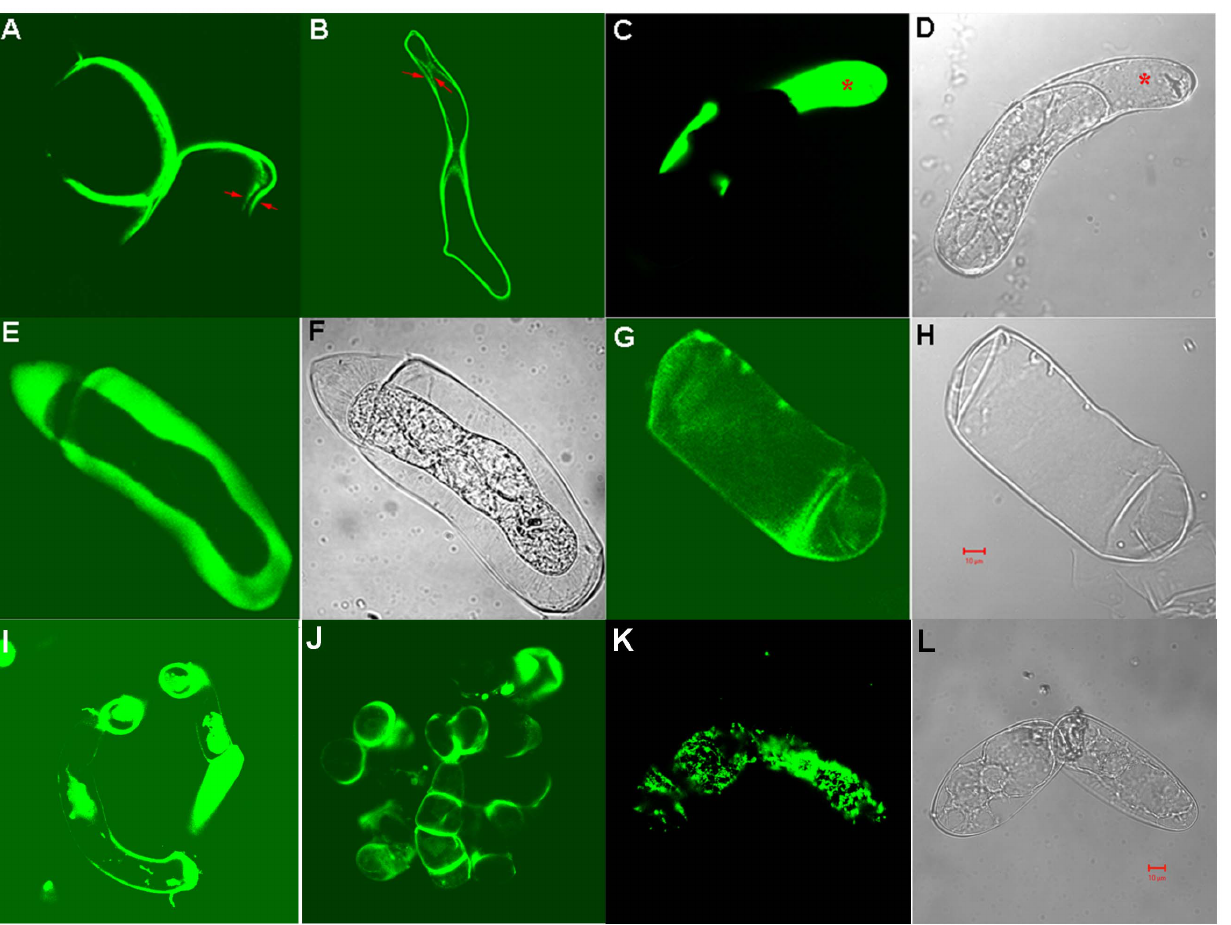
Fig. 3. Transgenic cells under confocal microscope. Panels A to H were images of 442-EGFP cells, among which cells in A to D were in liquid culture media. Arrows in A and B labeled the plasma membrane and cell wall respectively, showing 442-EGFP in the cell wall. The * labeled area of cell in C and D showed accumulation of 442-EGFP between the plasma membrane and the cell wall under normal suspension culture condition. Panels E and F were images of cells in 1 M mannitol, while G and H were cell walls prepared after sonication and wash with 2M NaCl and water. Panels I and J were images of 224-EGFP and 242-EGFP cells in 1 M mannitol, respectively; panels K and L were images of control YL8-EGFP cells in 1 M mannitol, in which the green fluorescence was mainly distributed on the plasma membrane. YL8-EGFP stands for gene encoding (SP 4 SPSP 4 YYYL) 8 -EGFP fusion protein [17]. Except panels D, F, H, and L were taken under normal light, other panels showed cells under excitation at 480 nm and emission at 520 nm. Scale bar: 10 m m. Panel A-H share the same scale bar, and panel I-L share the same scale